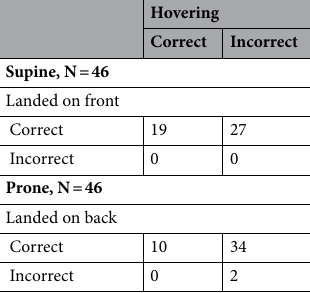
Table 1. Judgment of breathing. McNemar’s analyses were performed (p < 0.01, respectively).